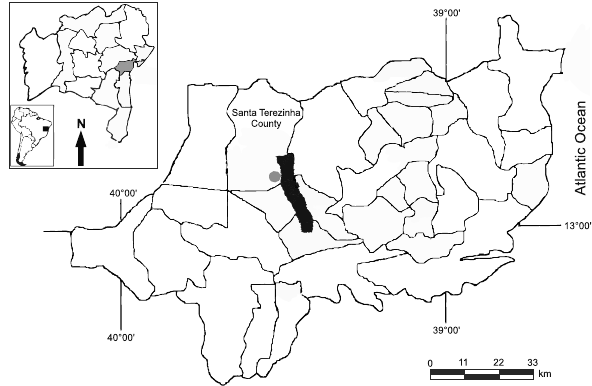
Figure 1. Map of southeast Bahia. Black area, Serra da Jibóia; gray spot, sampling site at Pedra Branca